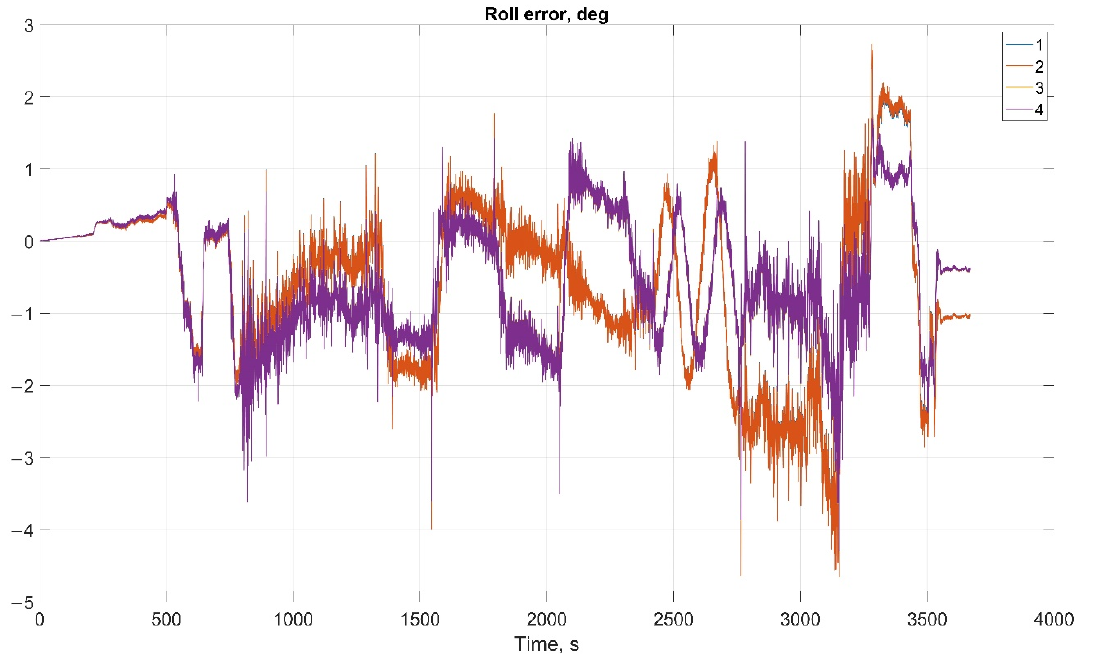
Figure 21. Roll error in helicopter test (1, Transformation matrix approach; 2, Direct angles calculation approach; 3, Transformation matrix approach using GNSS data; 4, Direct angles calculation approach using GNSS data).